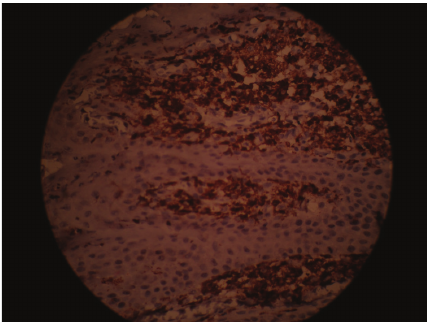
Figure 5: The infiltrated foam cells in the papillary dermis were CD68 positive (IHC stain 40x).